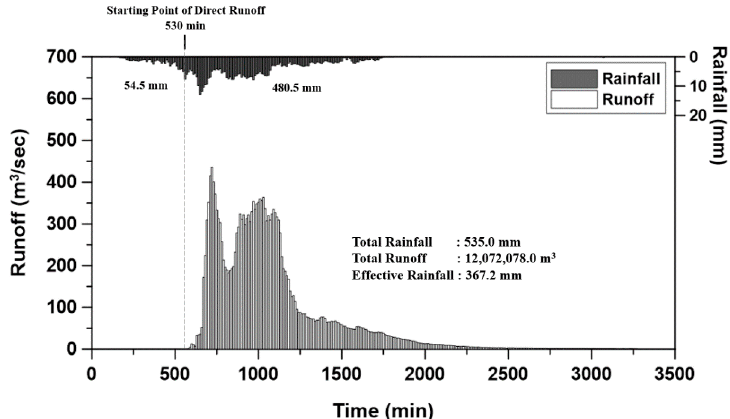
Figure 5. Determination of the initial abstraction in this study (rainfall event #3).